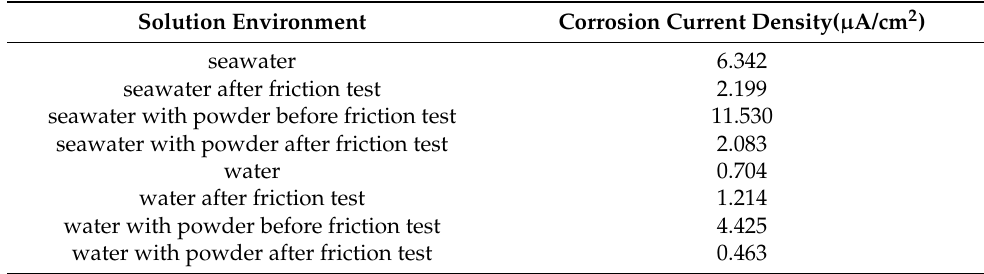
Table 8. Comparison of the corrosion current density with and without UHMWPE powder before and after friction and wear tests.